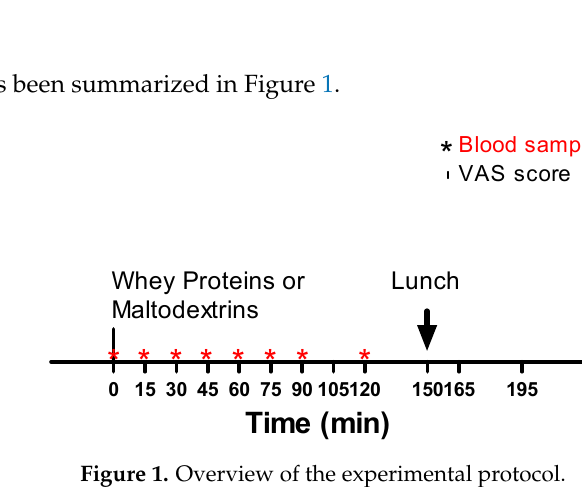
Figure 1. Overview of the experimental protocol.